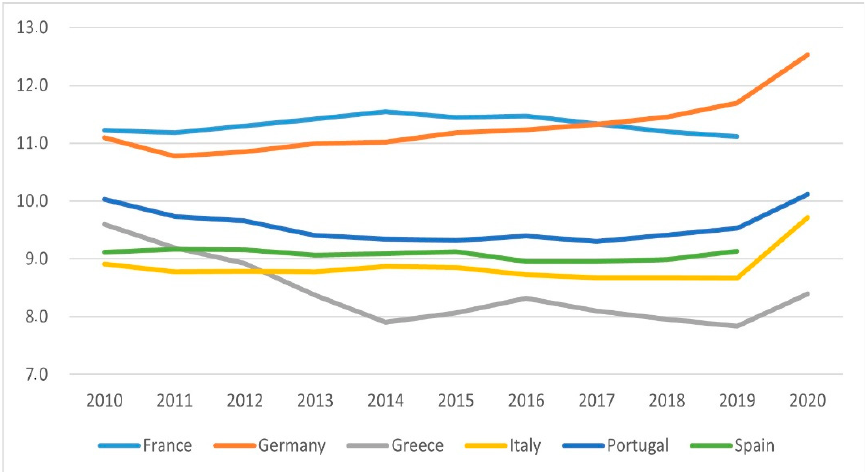
Figure 2. Current Expenditure on Health (all functions, all providers, %GDP) /Source: OECD, own calculations.